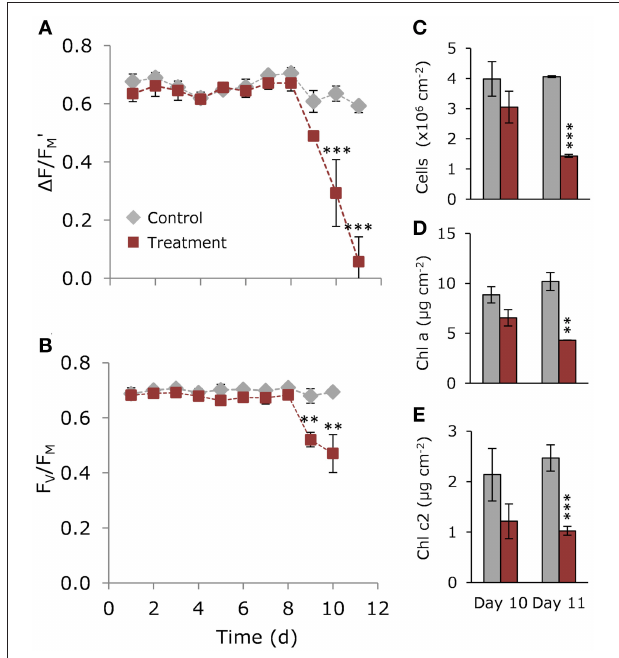
FIGURE 2 | Coral physiological condition over time. (A) Effective quantum yield ( 1 F/F M ′ ) and (B) maximum quantum yield (F V /F M ) of PSII over time for control (gray) and heated (red) corals. (C) Cell density (D) chlorophyll a and (E) chlorophyll c2 ( µ g cm − 1 ) in control (gray) and heated (red) corals on days 10 and 11. Data represent means ± SE. ( n = 3). Asterisks denote treatment is significantly different from the control over time: ** P < 0.01; *** P <